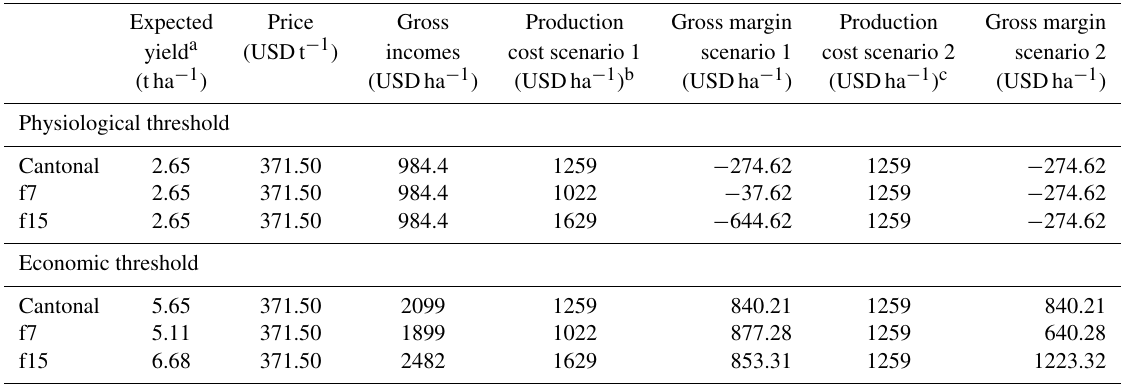
Table 7. Indemnity calculation for physiological and economic thresholds, for each AHZ (f7 and f15) and cantonal zone, both in scenario 1 and 2.